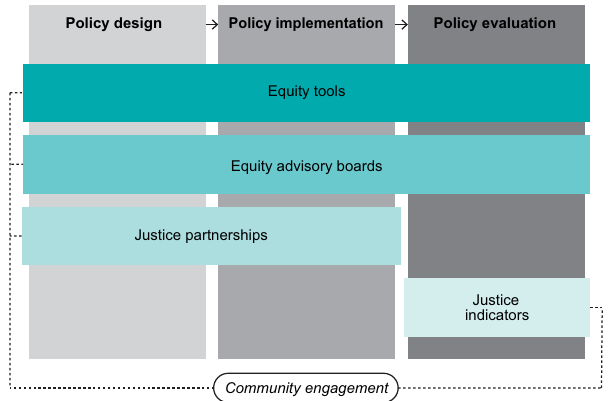
Fig. 3 | Policy tools and strategies to develop just climate policies. Equity tools and equity advisory boards can be implemented throughout the policy process. Justice partnerships are mainly focused on policy design and implementation. Jus- ticeindicators areusedduringpolicyevaluation.Allpolicytoolsandstrategiesmay involve community